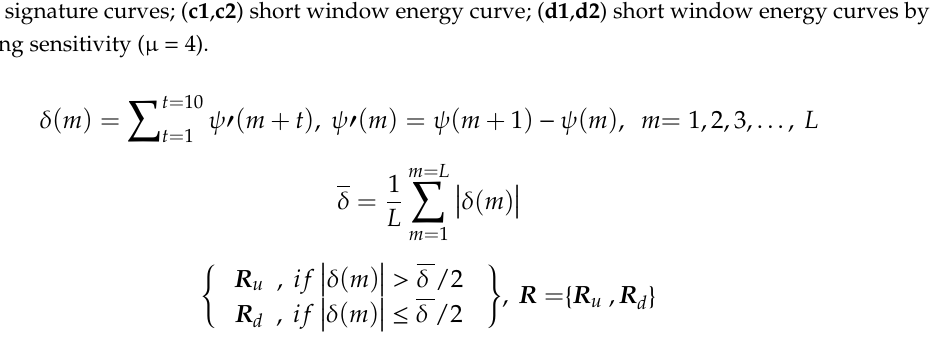
Figure 7. Micronucleus detection of real cell nuclei images: ( a1 ), ( a2 ) contour of cell regions; ( b1 ), ( b2 ) signature curves; ( c1 ), ( c2 ) short window energy curve; ( d1 ), ( d2 ) short window energy curves by screening sensitivity ( μ = 4).